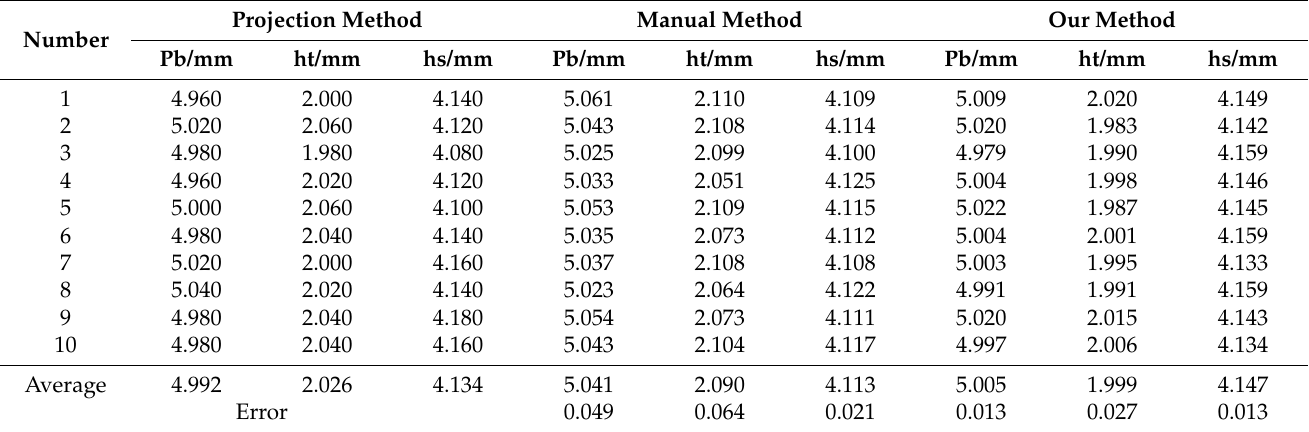
Table 1. Measurement data of tooth profile parameters.